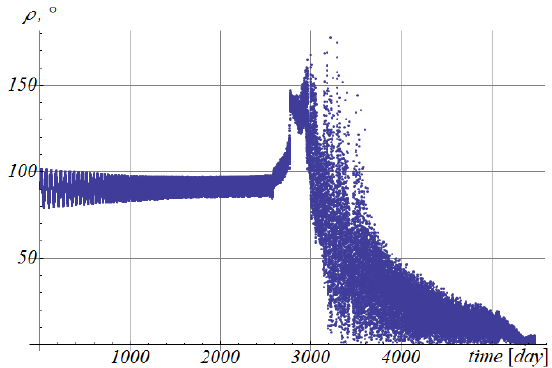
Figure 7. Evolution of angle ρ in scenario 2.